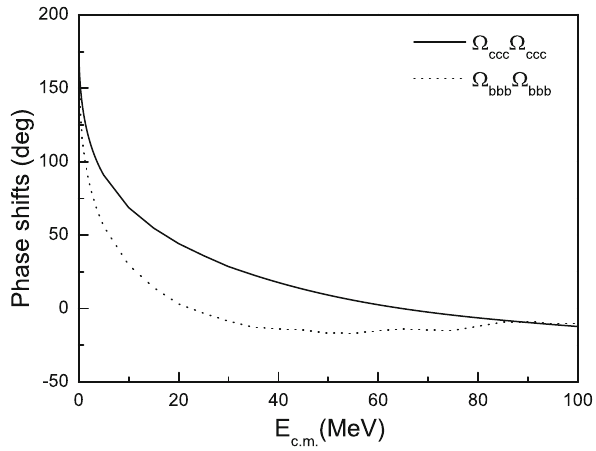
Fig. 4 The phase shifts of the S -wave Ω ccc Ω ccc and Ω bbb Ω bbb sys- tems with J P = 0 +